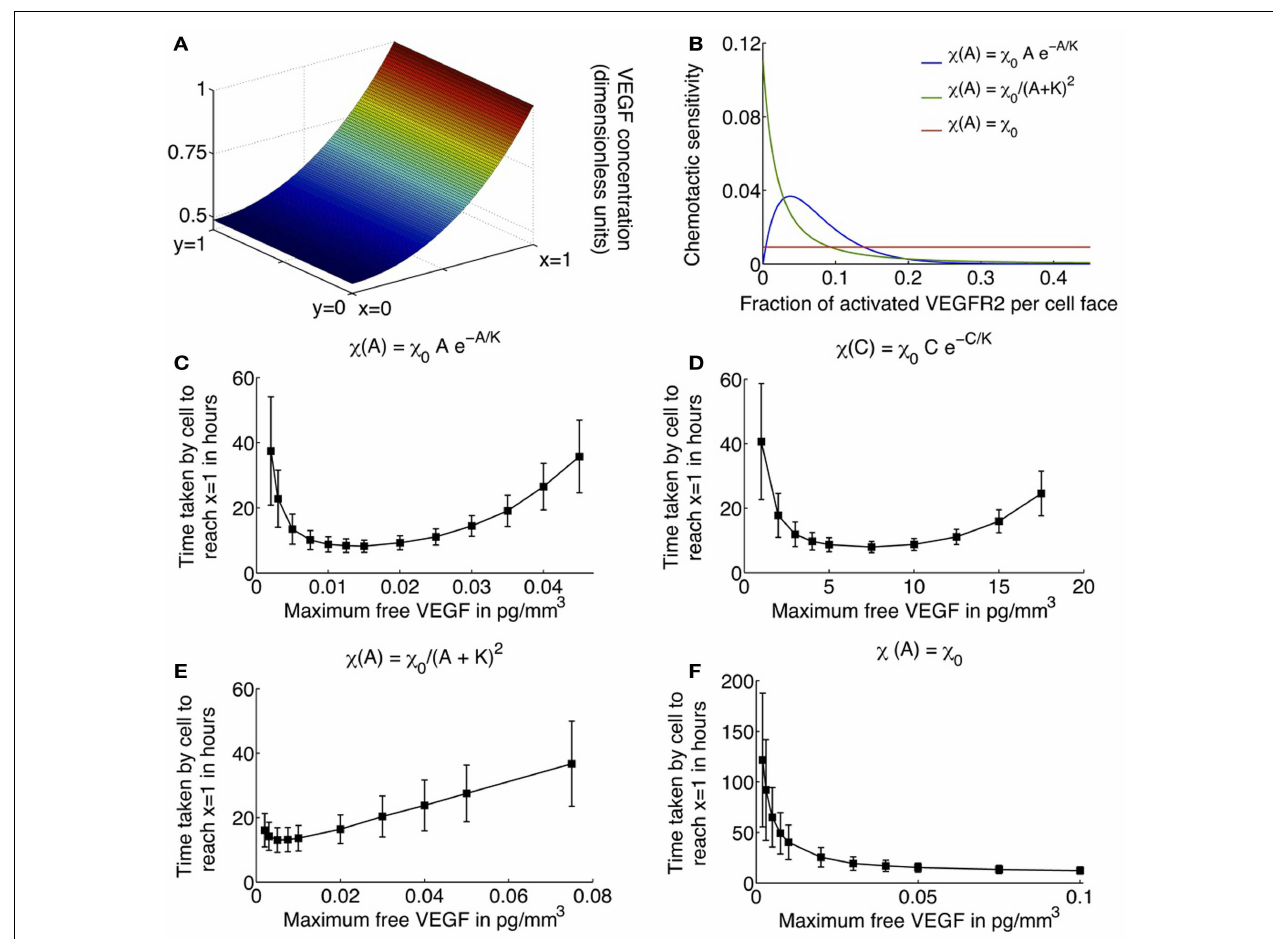
assumed to respond to activatedVEGFR2 on their surfaces, with chemotactic sensitivity taken as: (C) as proposed in equation (8); (D) cells are assumed to respond to freeVEGF with chemotactic sensitivity as defined in equation (8) with activated receptor concentration A replaced by freeVEGF concentration C ; (E) receptor-kinetic law, for which τ ( A ) = e χ 0 A/ ( KDp ( K + A )) , χ = 0.4416(pg/mm 3 )mm 2 /h, K = 2 pg/mm 3 ; and (F) 0 constant, χ 0 = 0.0046mm 2 /(pg/mm 3